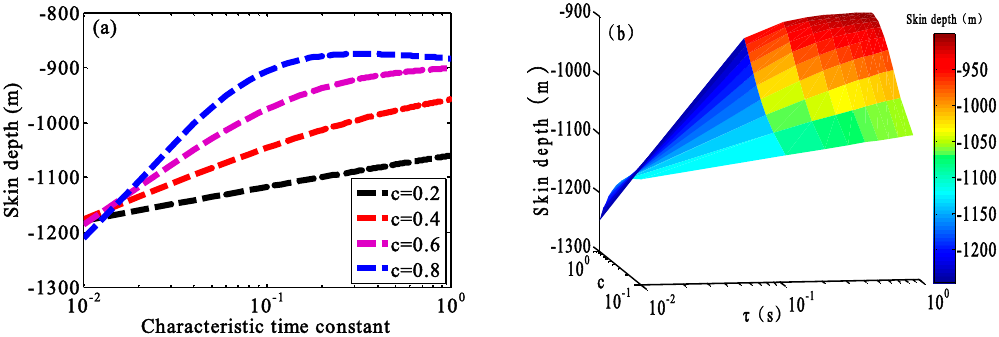
Figure 10. The e ff ect of the characteristic time constant and the frequency dependence on the skin depth (( a ) 2D curve, ( b ) 3D